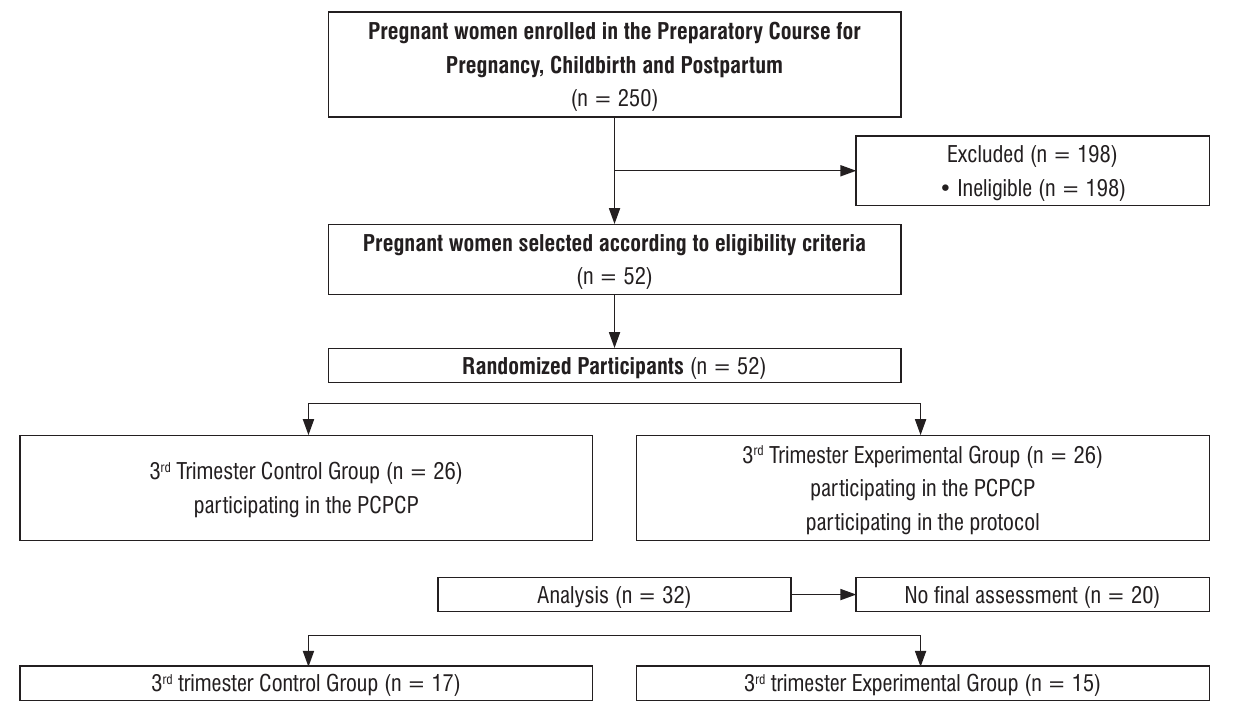
Figure 1 - Study distribution flowchart according to